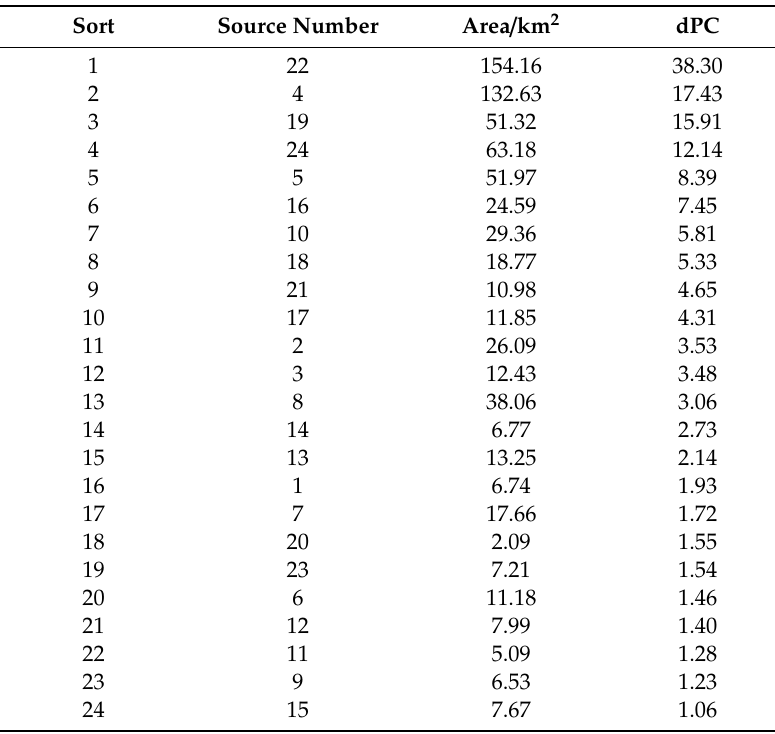
Table 5. The importance of source landscape connectivity index.